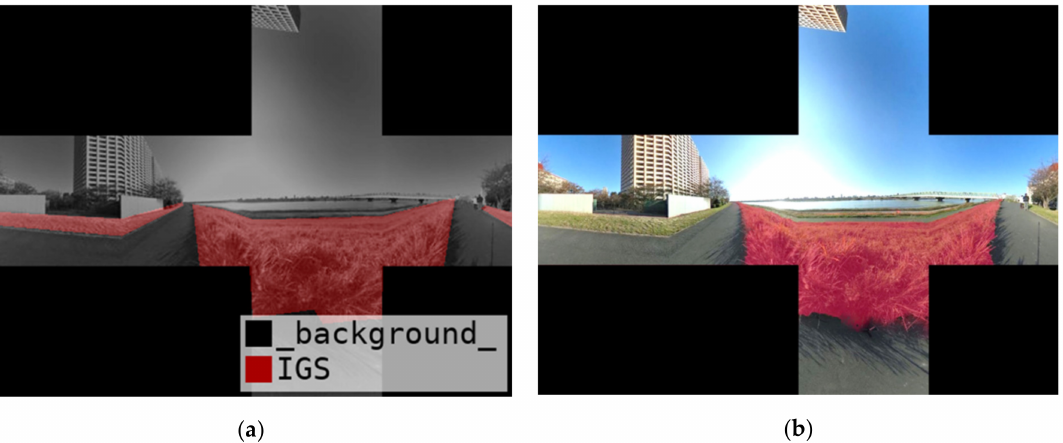
Figure 7. Visualization of the evaluation result. The sample image ( a ) with manually marked IGSs serves as a reference to evaluate the accuracy of the result ( b ), which is generated using a new training